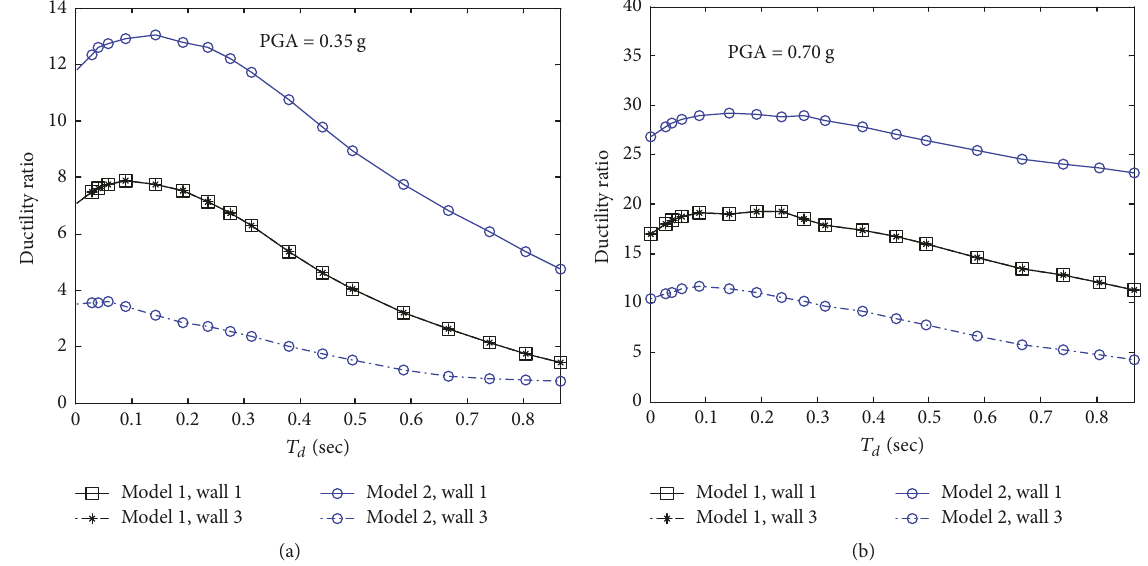
Figure 15: Ductility demands of weak (wall 1) and strong (wall 3) walls of model 2: (a) DBE earthquake (0.35 g) and (b) MCE earthquake (0.70